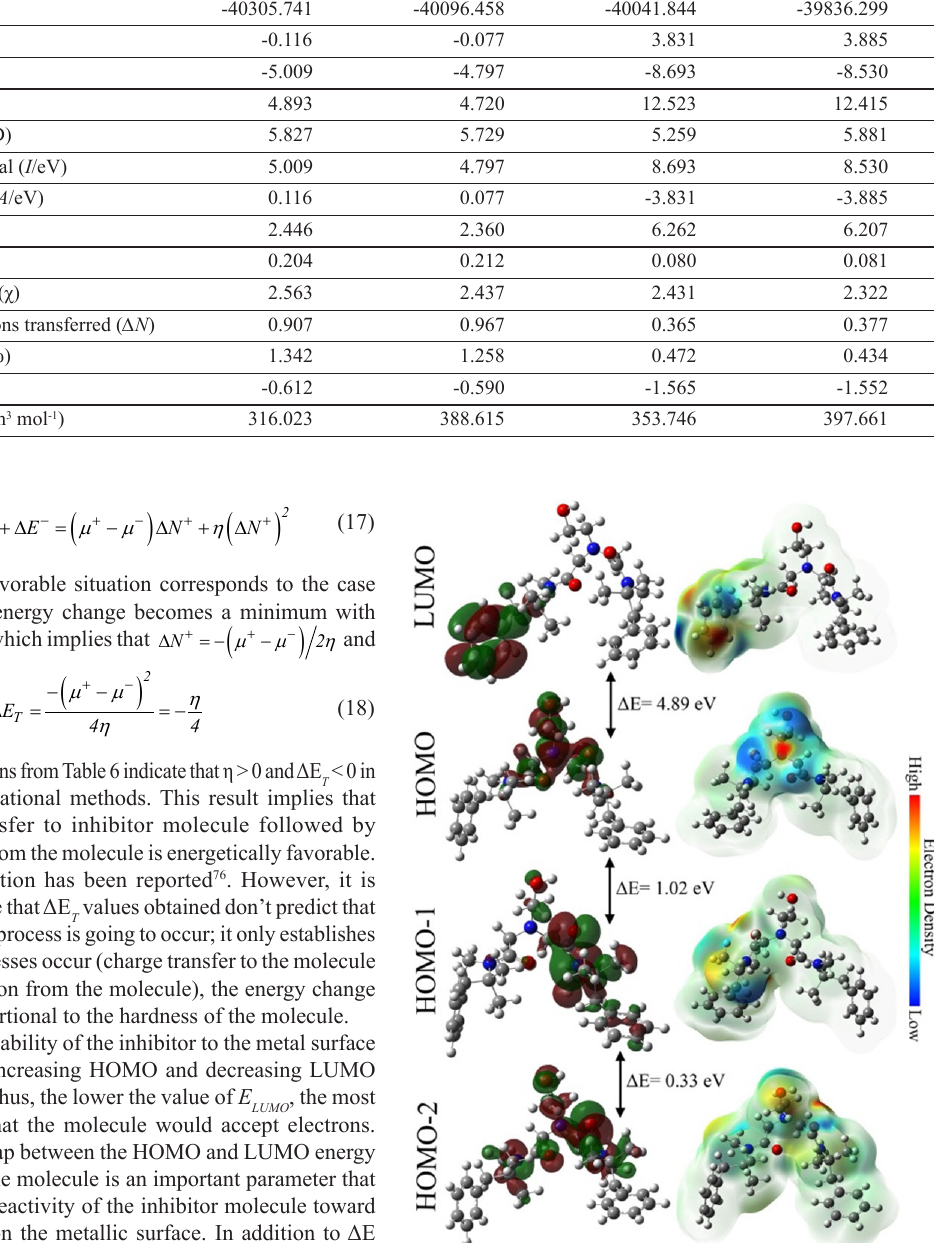
Table 6. Some quantum chemical parameters for oxetacaine obtained at (A) B3LYP/6-31G(d,p), (B) B3LYP/3-21G, (C) HF/6-31G(d,p) and (D) HF/3-21G. quantum chemical properties